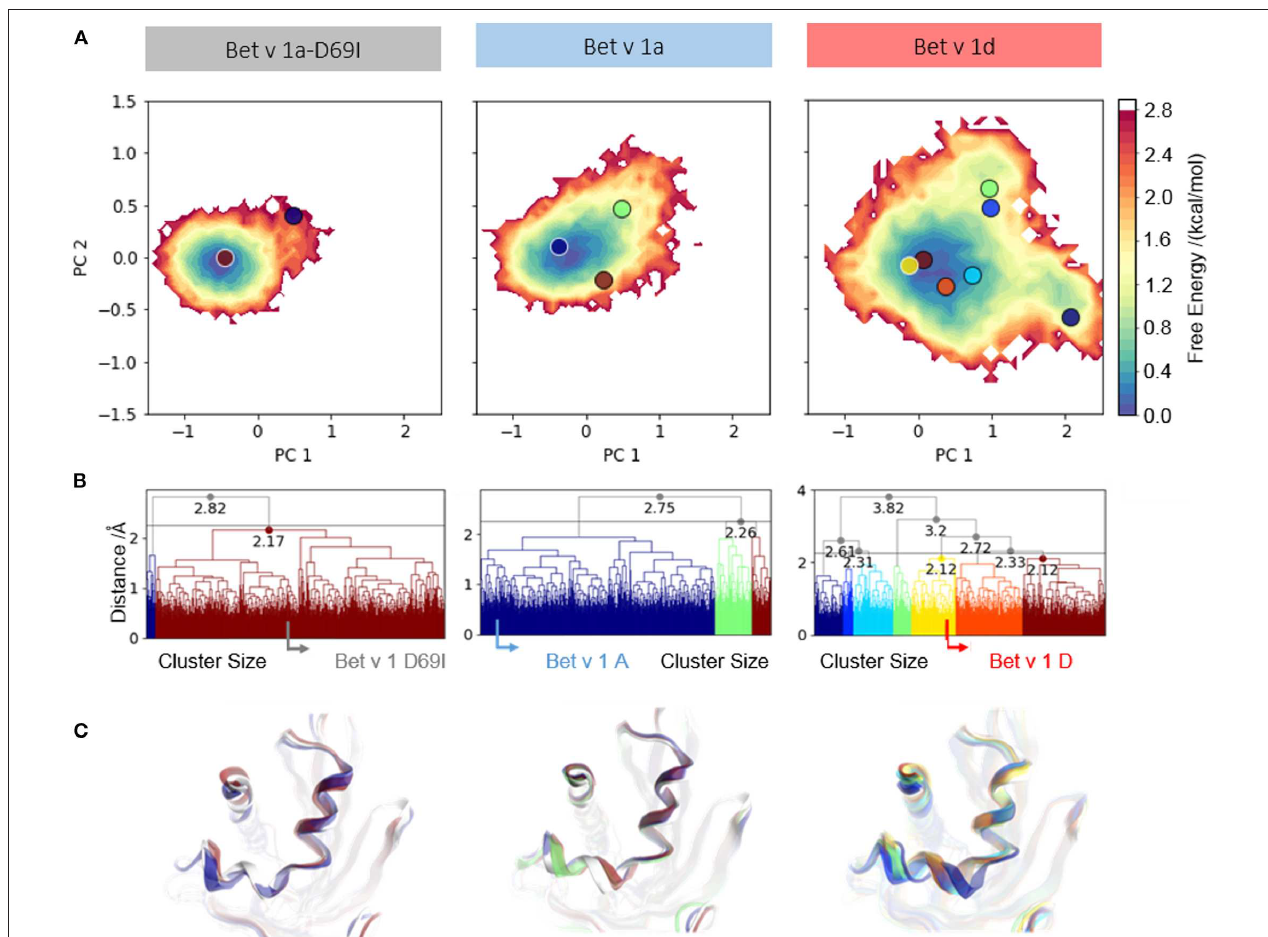
FIGURE 2 | Conformational space of residues around the early cleavage site of Bet v 1 variants. (A) The captured ensembles were color-coded according to Gibbs free energies and projected onto the first two eigenvectors of the combined PCA space. (B) Clustering of the conformational space of helix 1 and helix 2 resulted in two clusters for the stabilized variant Bet v 1a-D69I , three clusters for the wild-type protein Bet v 1a and seven clusters for the destabilized variant Bet v 1d , at a distance cut-off of 2.5 Å. The native structure of each variant is denoted with an arrow in the respective dendrogram. (C) Representative structures were extracted from each cluster to visualize conformational differences and were projected onto the PCA